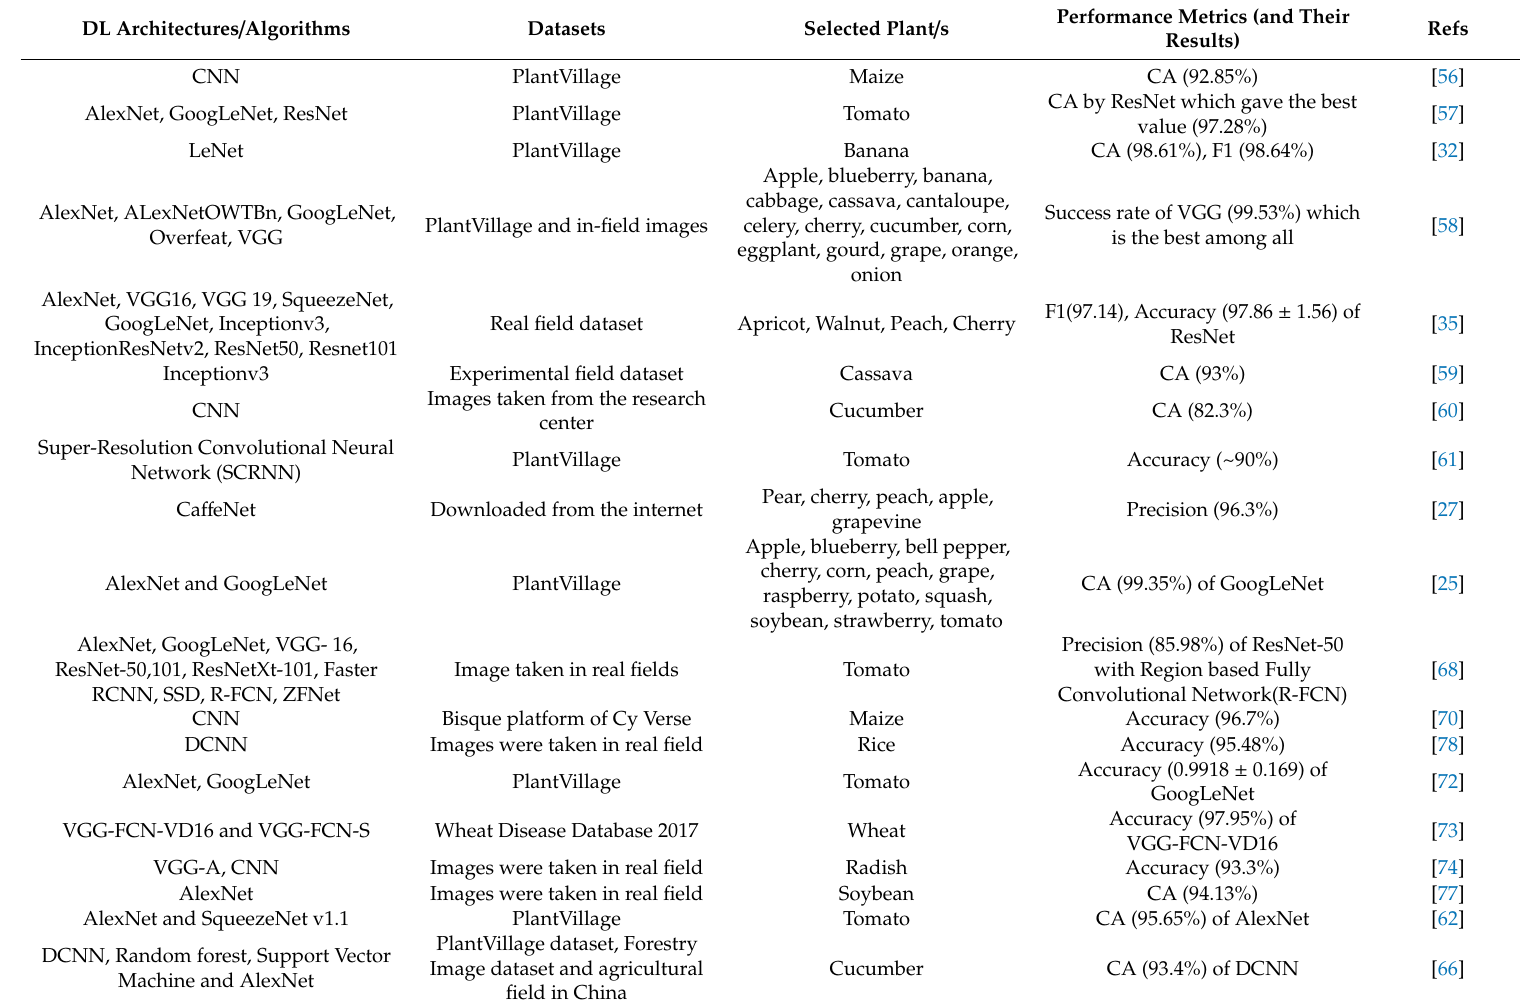
Table 3. Comparison of several DL approaches in terms of various performance